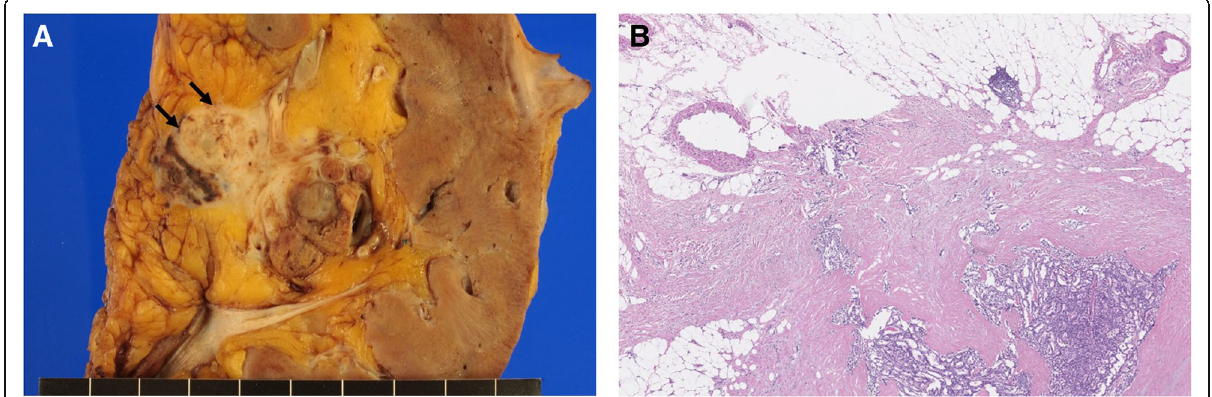
Fig. 1 One case exhibited extension to the renal sinus fat on gross finding ( a ) and microscopic finding ( b , ×